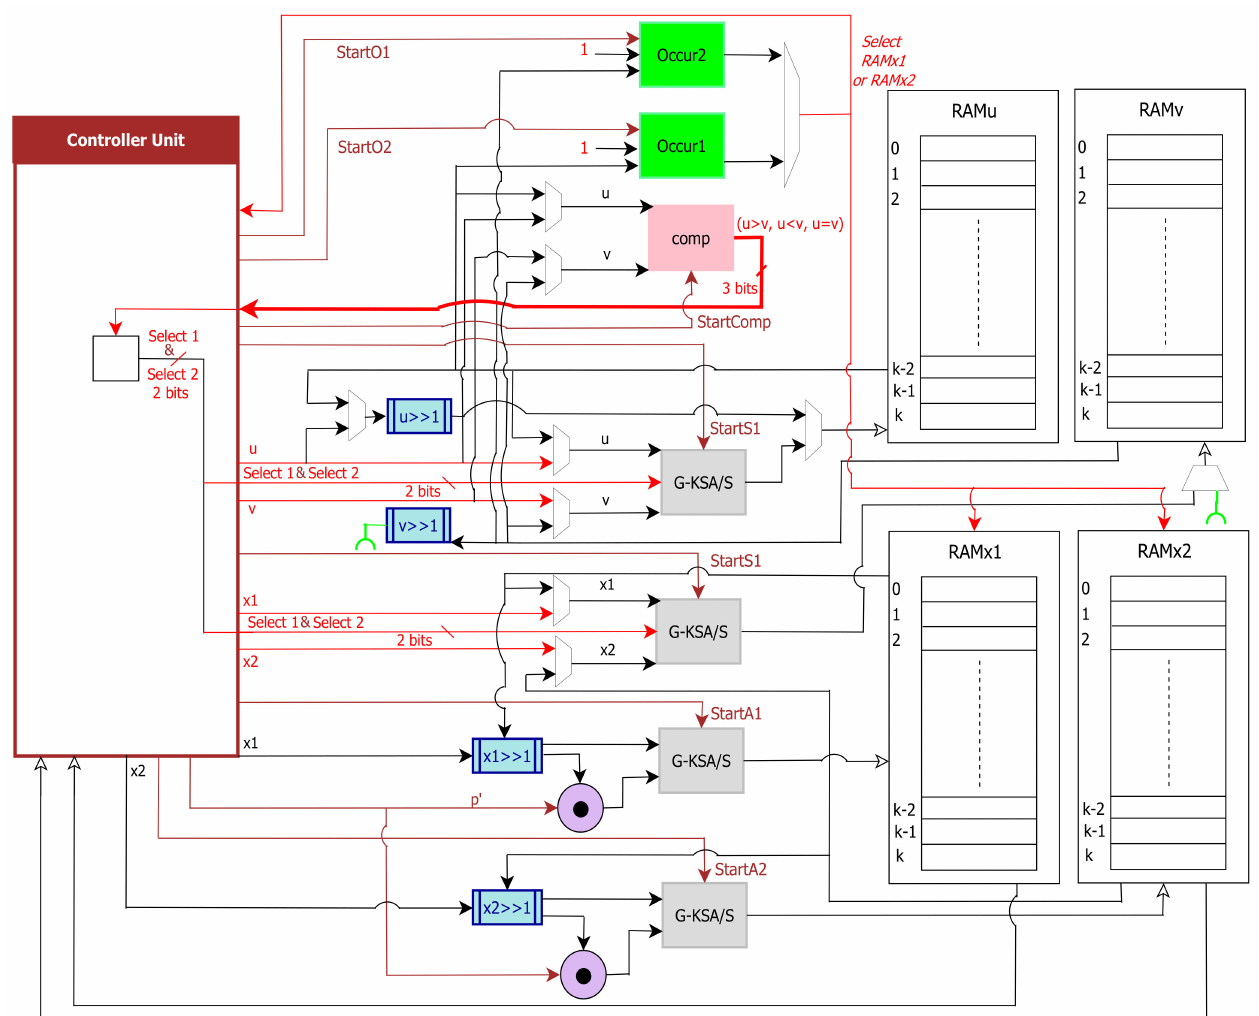
Figure 3. Proposed MBEEA